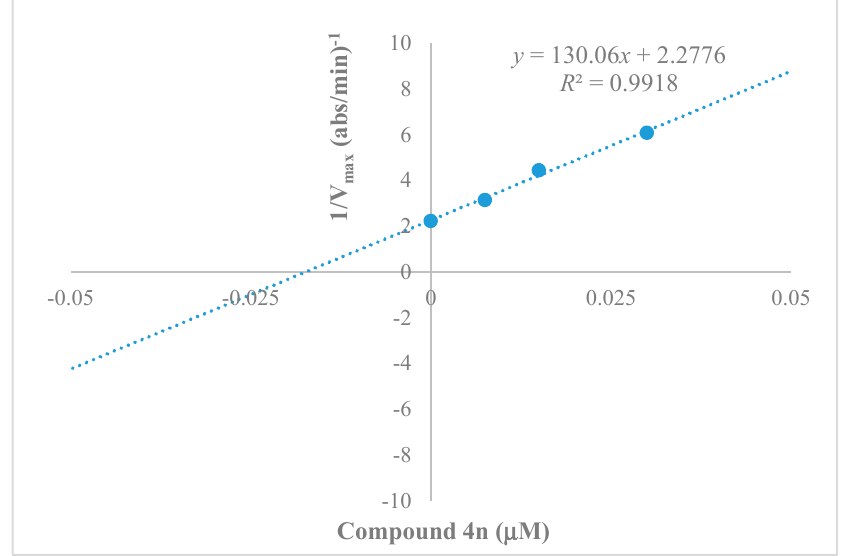
Figure 3. Secondary plot for calculation of the steady-state inhibition constant (K i = 0.0175 µM against BChE) of compound 4n .